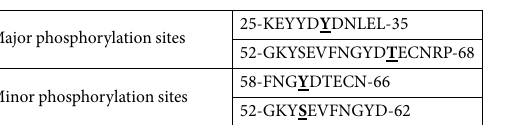
Table 1. Phosphorylation sites (bold and underlined) identified in the recombinant Pf CK2 α derived from this